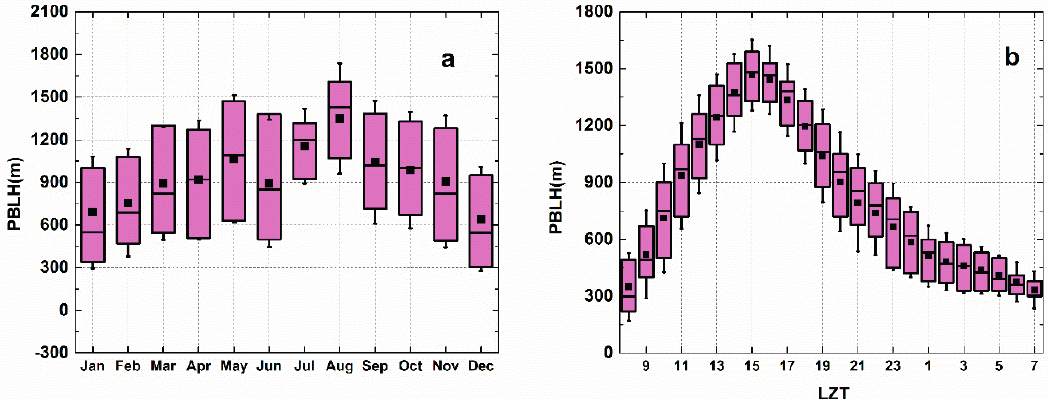
Figure 5. Box-and-whisker plots of seasonal and diurnal variation of planetary boundary layer height (PBLH). The plots illustrate the mean value (solid black square), median (horizontal bar in box), 25th and 75th percentiles (lower and upper ends of box), standard deviation (horizontal upper and lower lines): ( a ) seasonal variation of PBLH; ( b ) diurnal variation of PBLH.